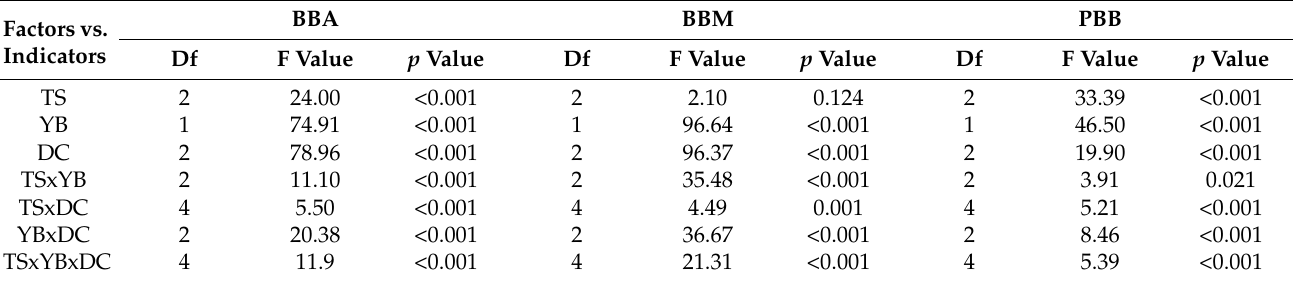
Table 4. Three-way ANOVA evaluating the influence of tree species (TS), year of browsing by large wild herbivores (YB), and diameter class (DC); browsed bark area (BBA), browsed bark mass (BBM), and browsed bark mass; and total bark mass (PBB) caused by large wild herbivores on the tree level.. Tree species were represented by common aspen ( Populus tremula L.), common rowan ( Sorbus aucuparia L.), and goat willow ( Salix caprea